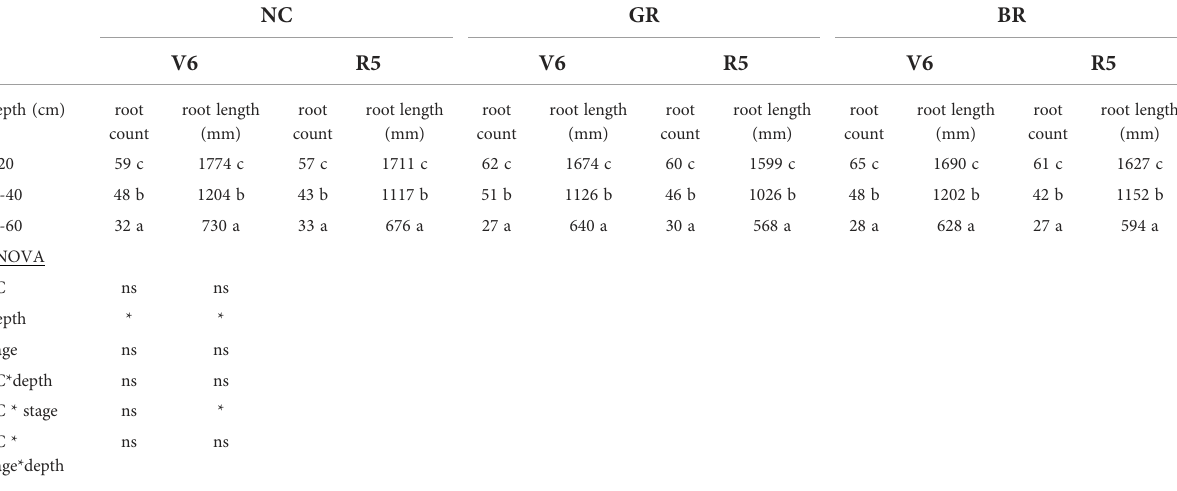
TABLE 5 Effect of cover crop (CC) treatments on soybean root count and root length at different depths in soybean-rye rotation study at Stoneville, MS.